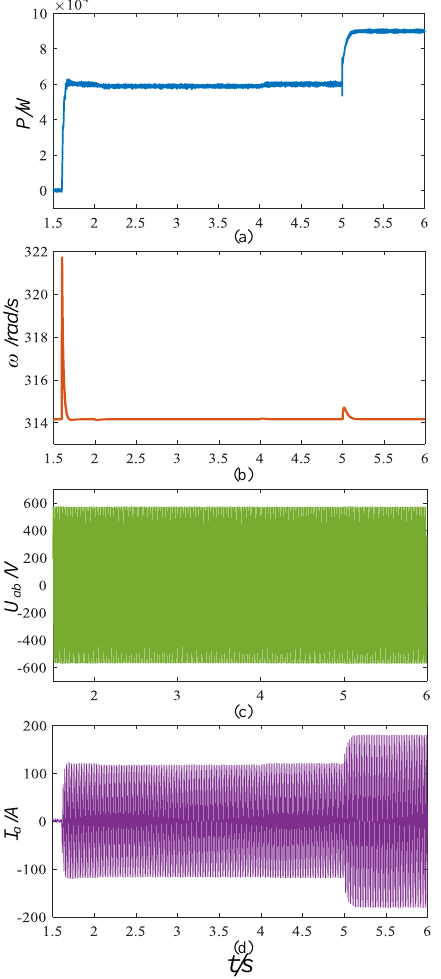
Figure 14. The waveforms of VVSG output active power, angular frequency, line voltage, and phase current during control algorithm switch and active command step. ( a ) VVSG output active power; ( b ) VVSG output angular frequency; ( c ) VVSG output line voltage; ( d ) VVSG output phase current.